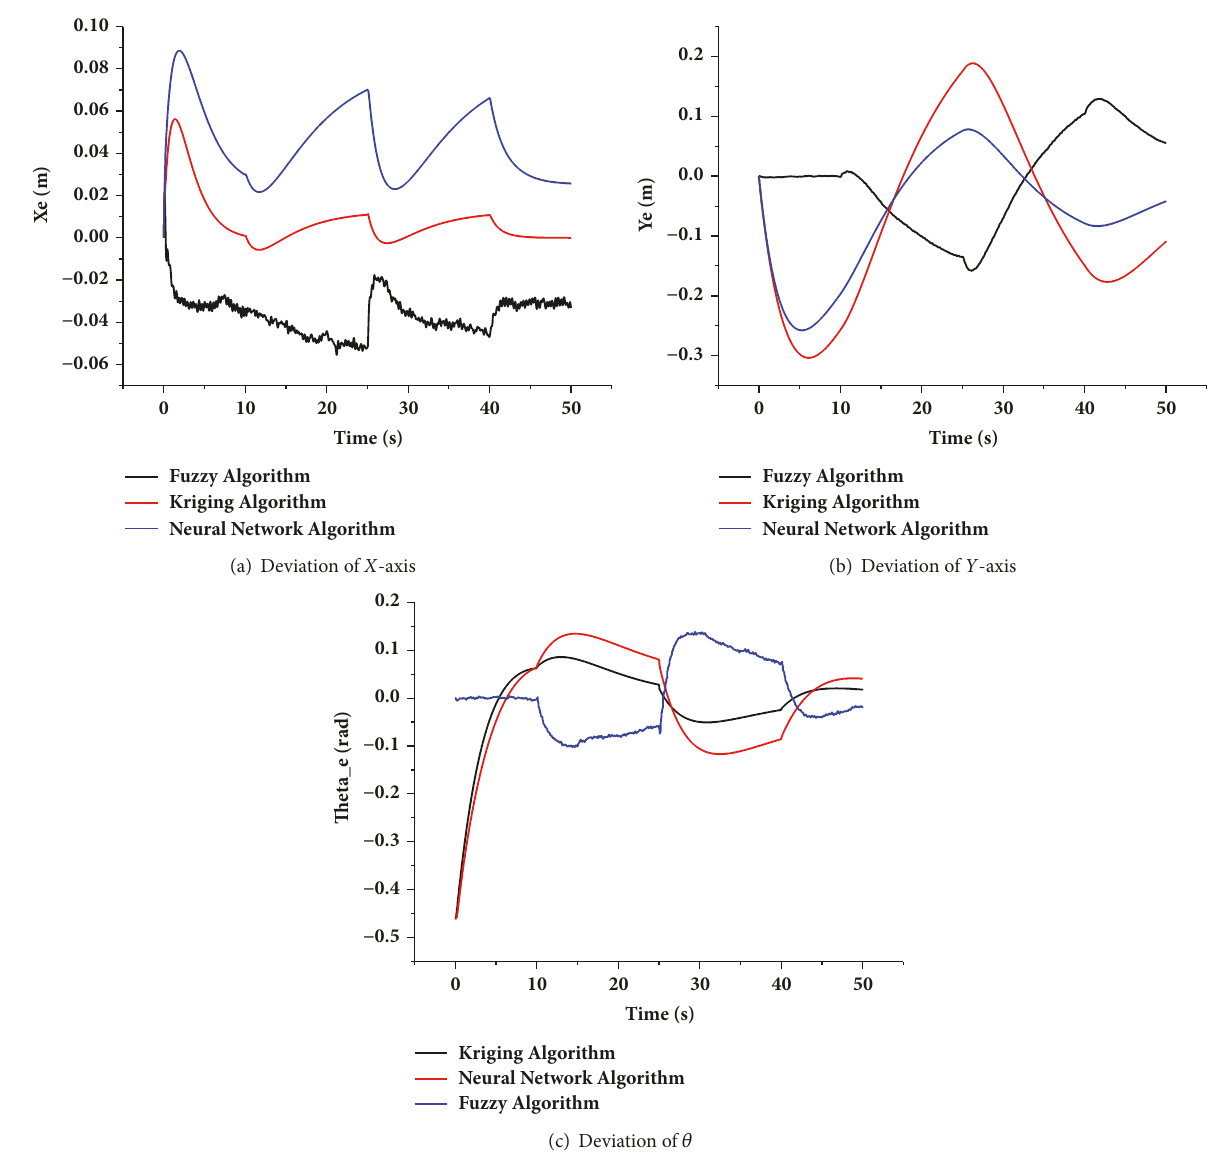
Figure 11: Result analysis of